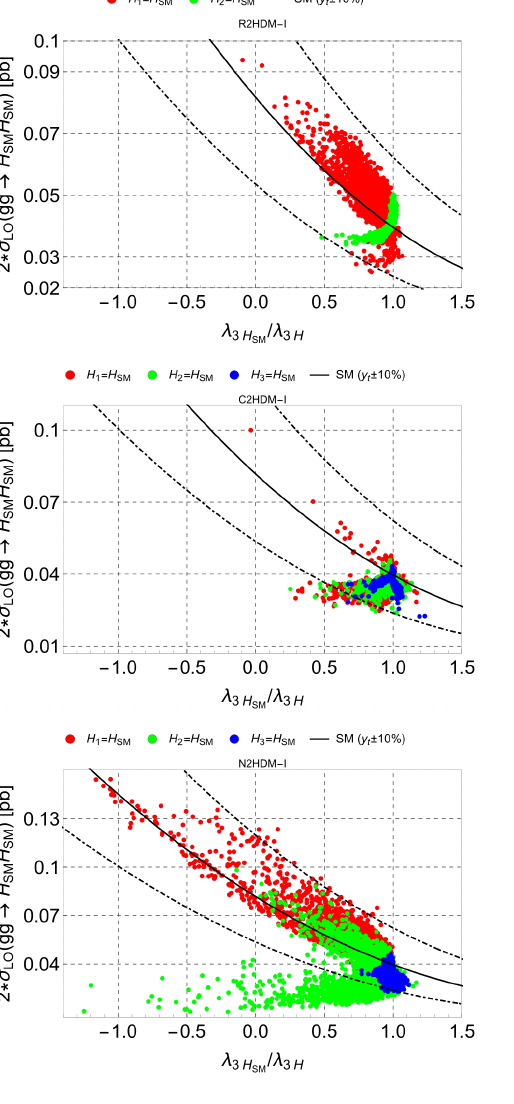
Figure 17 . Non-resonant di-Higgs cross sections for the R2HDM (upper), C2HDM (middle) and N2HDM (lower) points of figure 8 for type 1 (left) and type 2 (right) as a function of the trilinear Higgs self-coupling of the SM-like Higgs boson of the respective model normalized to the trilinear coupling of the SM Higgs boson. Note the different y -axis range in the results for the R2HDM and those for the C2HDM and N2HDM. The full line shows the change of the SM Higgs pair cross section as a function of the variation of the trilinear Higgs self-coupling, the dashed lines show the change, when additionally the SM top-Yukawa coupling is varied by ± 10